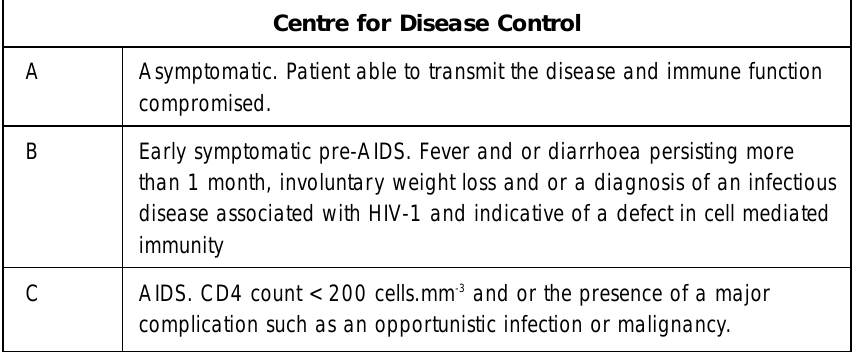
Table 2: Centre for Disease Control coding for